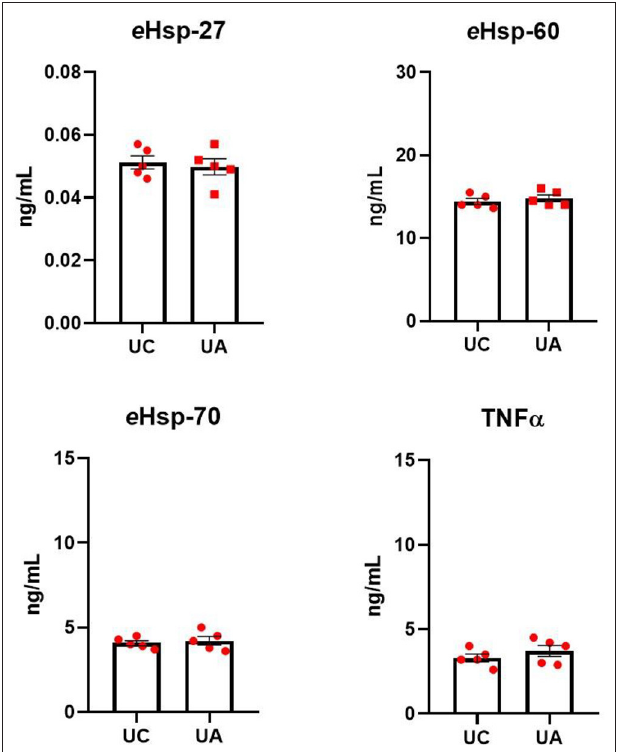
FIGURE 1 | Quantification of e Hsp-27, e Hsp-60, e Hsp-70, and TNF α in plasma from blood samples collected from the umbilical cord (UC) and the umbilical artery (UA) in healthy neonates at term ( n = 5). Concentration was expressed as ng/ml. Data represent the mean ± SEM.